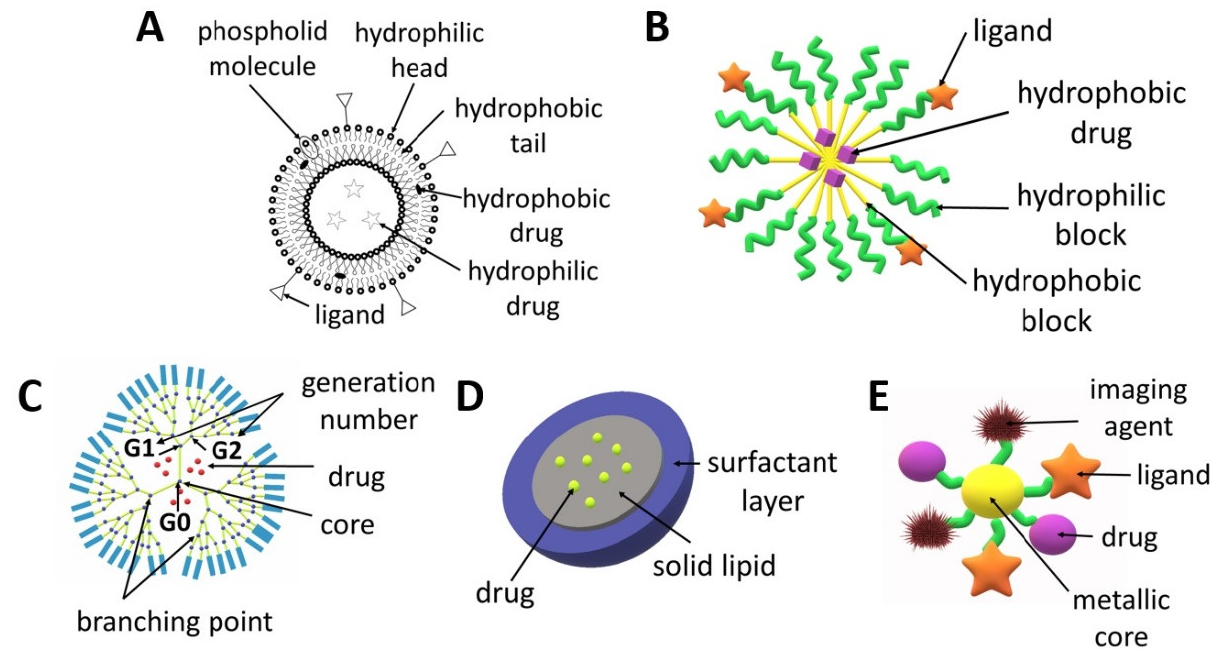
Figure 2. Scheme of the structures of drug delivery systems: ( A ) liposome, ( B ) micelle, ( C ) dendrimer, ( D ) solid lipid nanoparticle, ( E ) metallic nanoparticle. Dendrimers (Figure 2C) can be made of various compounds, e.g., poly(propylene imine) (PPI), poly(L-lysine), poly(amidoamine) (PAMAM) and PAMAM-organosilicon (PAMM-OS). They possess a predictable shape, size, molecular weight and structure, which allows for the design of carriers with specific properties (e.g., lipophilicity, affecting